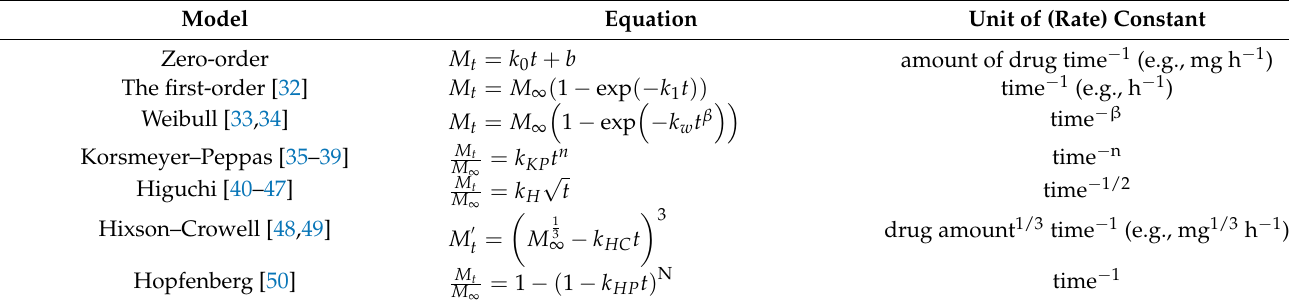
Table 1. Frequently used mathematical models to describe the drug dissolution profiles.